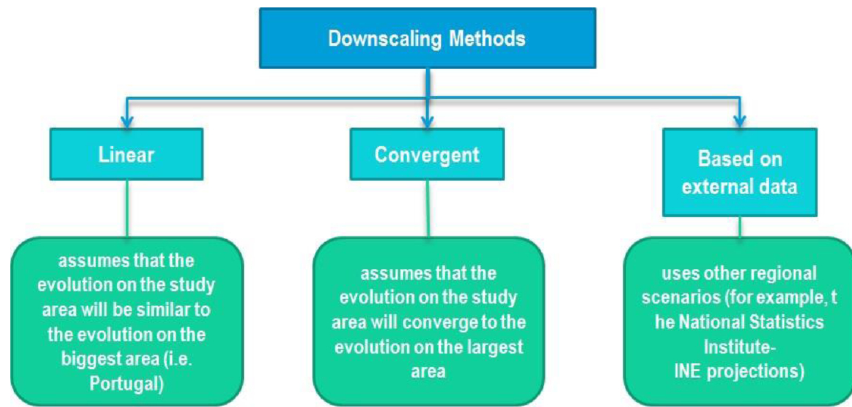
Figure 2. Downscaling methods in Socioeconomic Scenarios. Source: adapted from van Vuuren et al. (2010).